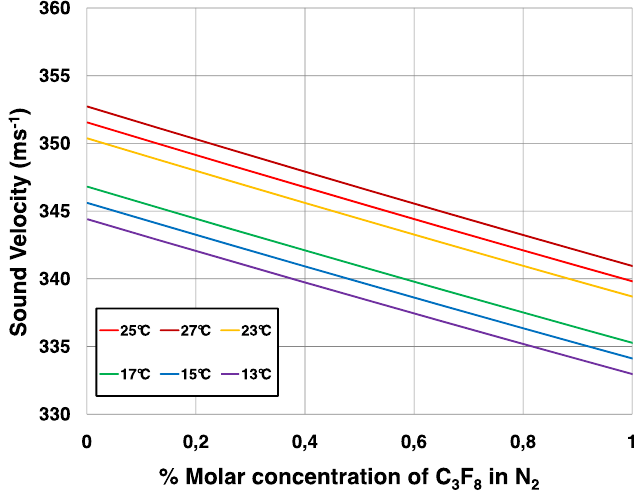
Figure 9. Sound velocity calculated according to the formalism of Equations (1)–(6) for CO /N mixtures in the molar concentration range (0%–0.1% CO 2 2